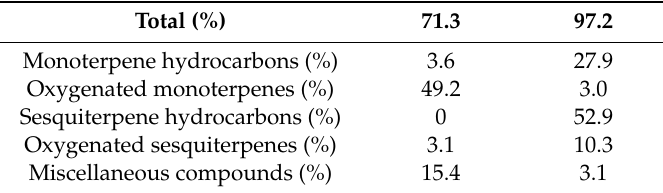
Table 3. Summary of the chemical compositions of HEO Fl and HEO Lv